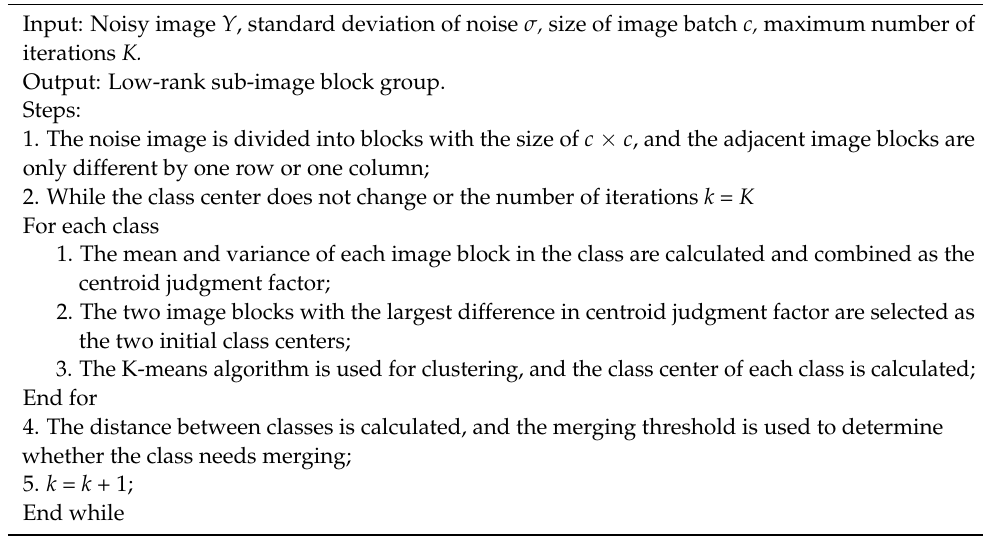
Algorithm 1: Adaptive clustering algorithm based on dichotomy